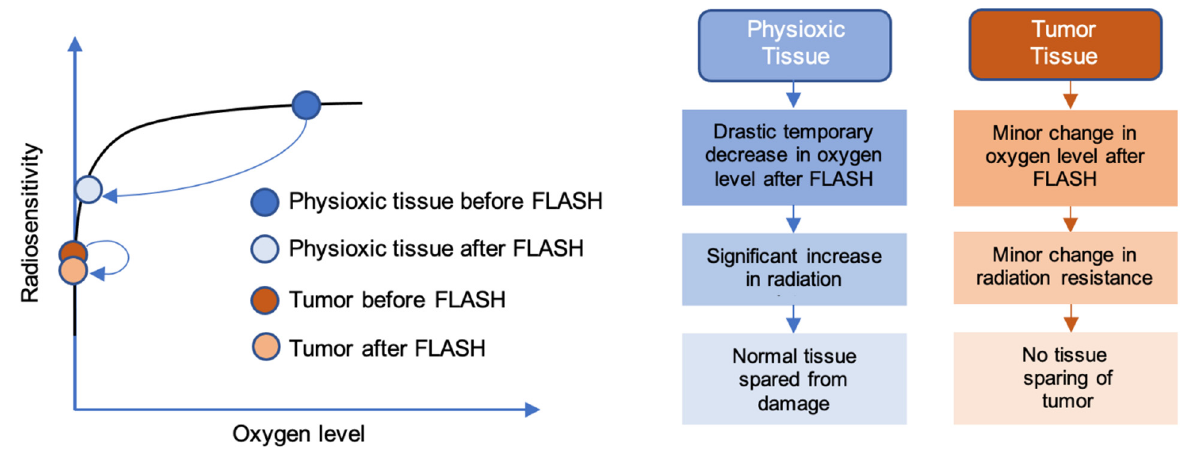
Figure 1. Oxygen depletion hypothesis of the FLASH effect. Tumors are extremely hypoxic relative to their surrounding normal tissue, with oxygen tensions ranging from 0.3% to 4.2%. The surrounding normal tissue is more highly oxygenated (i.e., physioxia), usually between 3% and 7.4% [36]. For this reason, a more pronounced decrease in oxygen level after FLASH treatment is observed in physioxic conditions compared with tumors. This correlates with a significant decrease in radiosensitivity (or increase in radiation resistance) in normal tissues, conferring the FLASH effect. Tumors, on the other hand, show little change in radiosensitivity, leading to the absence of the FLASH effect.